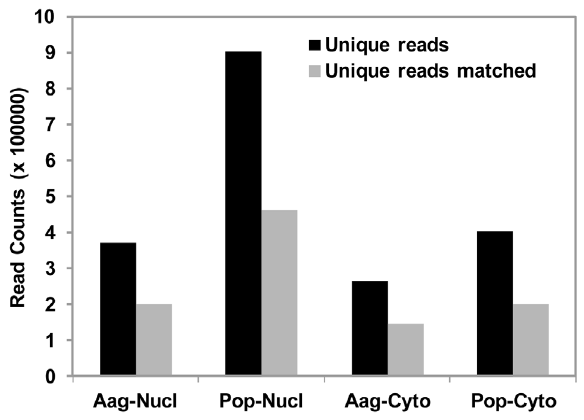
Figure 1. Number of unique reads and unique reads that matched the Ae.aegypti genome from the four libraries deep sequenced using RNA samples from the nucleus and the cytoplasm of Aag2 and Pop